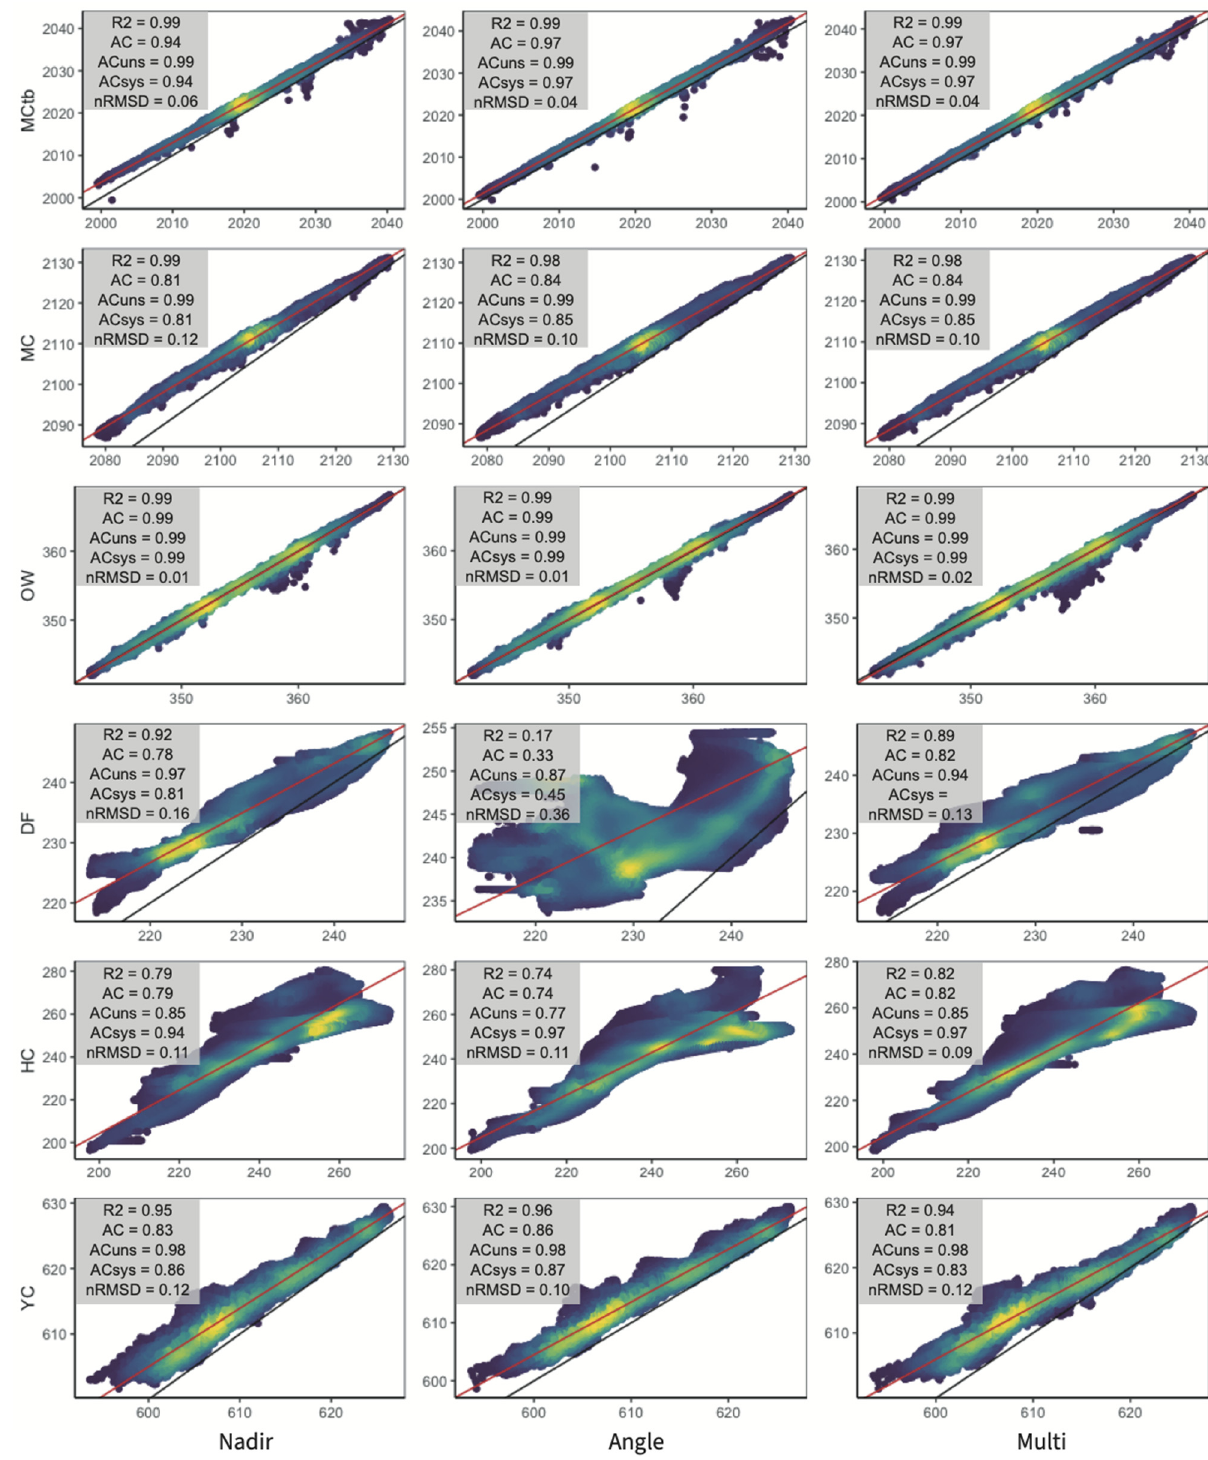
Figure 3. Comparison of site-specific digital terrain models (DTM) generated from UAS DAP (nadir, angled, and multi- angled) versus lidar. The X axis is DAP and the Y axis is lidar. Geometric mean fit regression line in red, 1:1 line in black, points are colorized by density of observations (i.e., number of raster pixels) with lighter regions (yellow) indicating greater density of observations and darker regions (blue) being less dense. R-squared, root mean square deviation (RMSD), normalized RMSD (nRMSD), agreement coefficient (AC), systematic agreement coefficient (AC sys ) and unsystematic agreement coefficient (AC uns ) are shown for each model comparison.